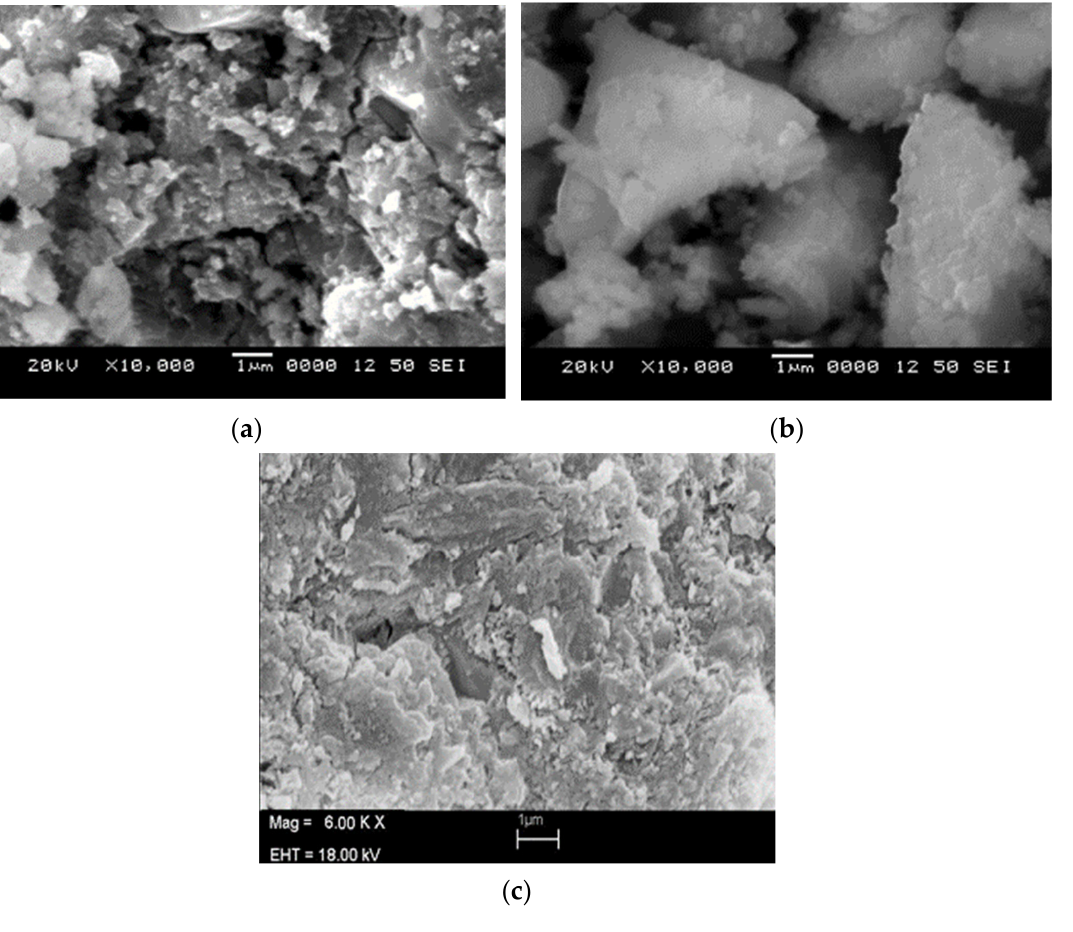
Figure 7. Attenuation for specimens with and without lead oxide reinforcement.